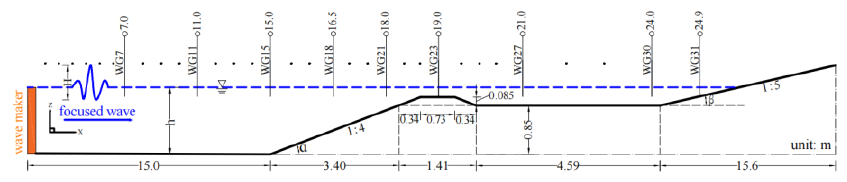
Figure 6. Computational layout.